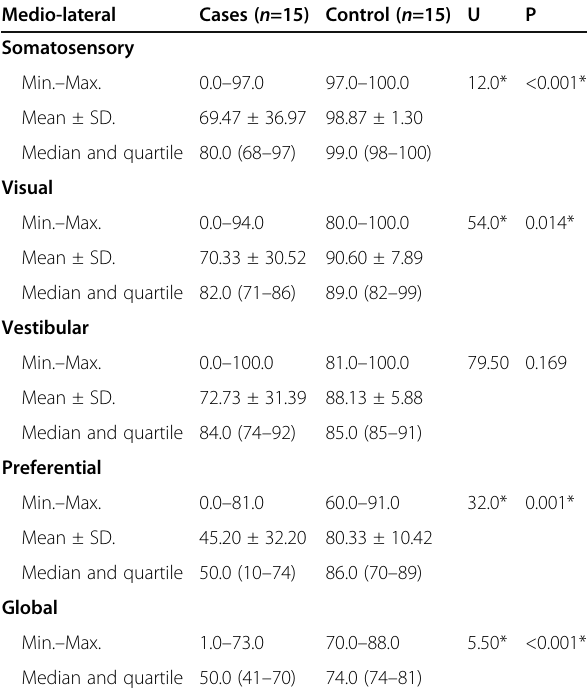
Table 3 Comparison of medio-lateral sensory balance scores of complete static sensory organization test between control and study groups ( n